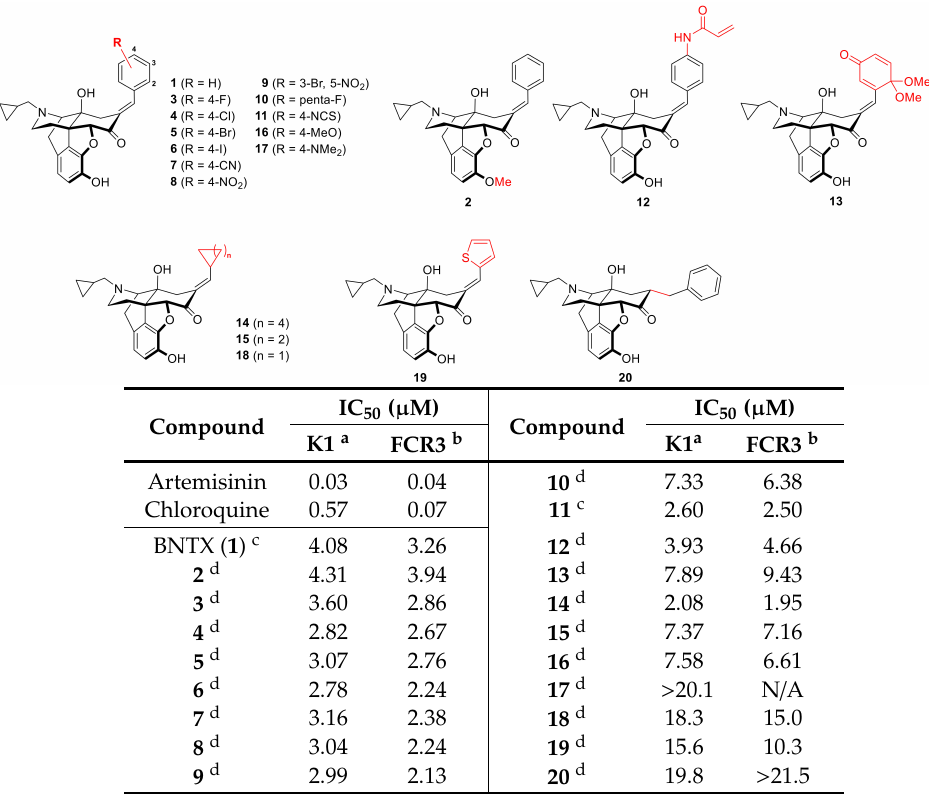
Table 1. In vitro antimalarial activity of the morphinan derivatives 1 – 20